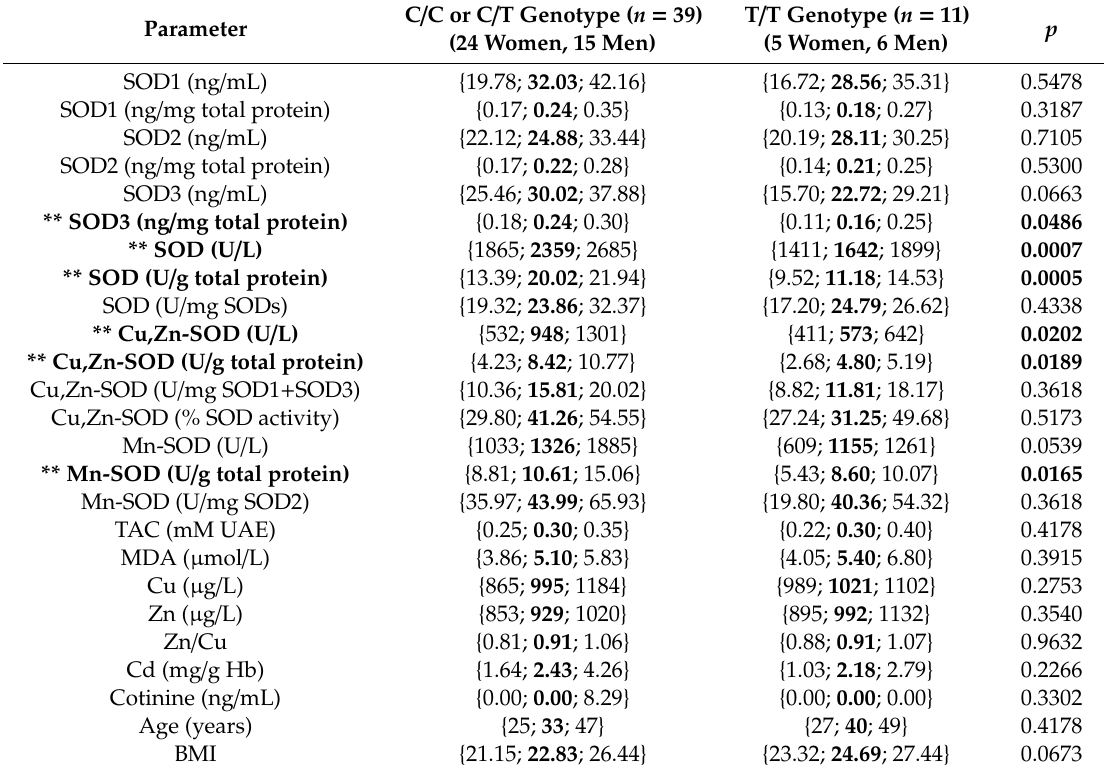
Table 11. Values of selected pro- and antioxidative parameters, and concentration of selected metals, in context of genotypic variability of rs4880 ( SOD2 ), in non-obese